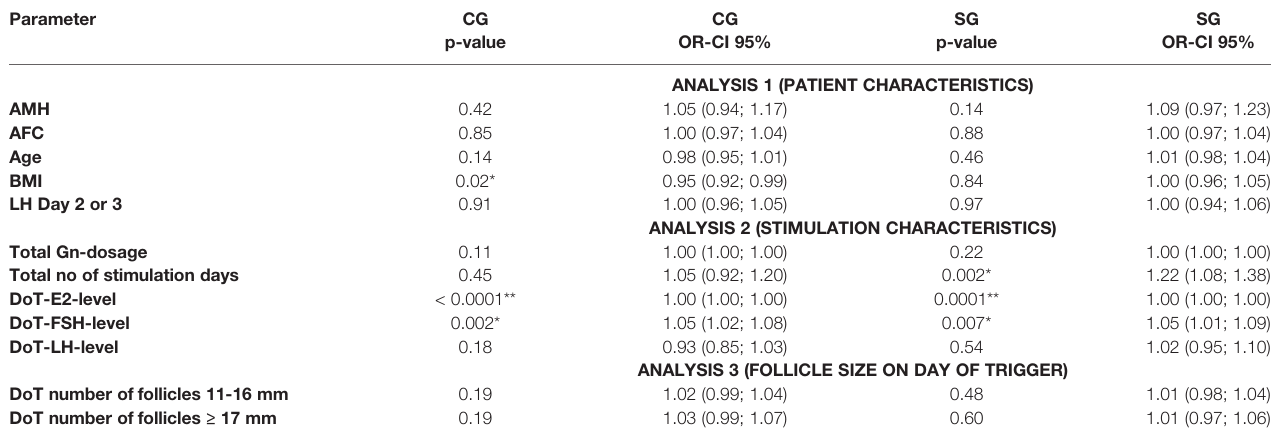
FIGURE 2 | Distribution of systemic FSH-levels on day of trigger (DoT) for control group (CG) and study group (SG). FSH, Follicle Stimulating Hormone. TABLE 4 | Multivariate analysis – correlation of DoT-P4-levels with patient characteristics, stimulation characteristics and follicle size. Parameter CG CG